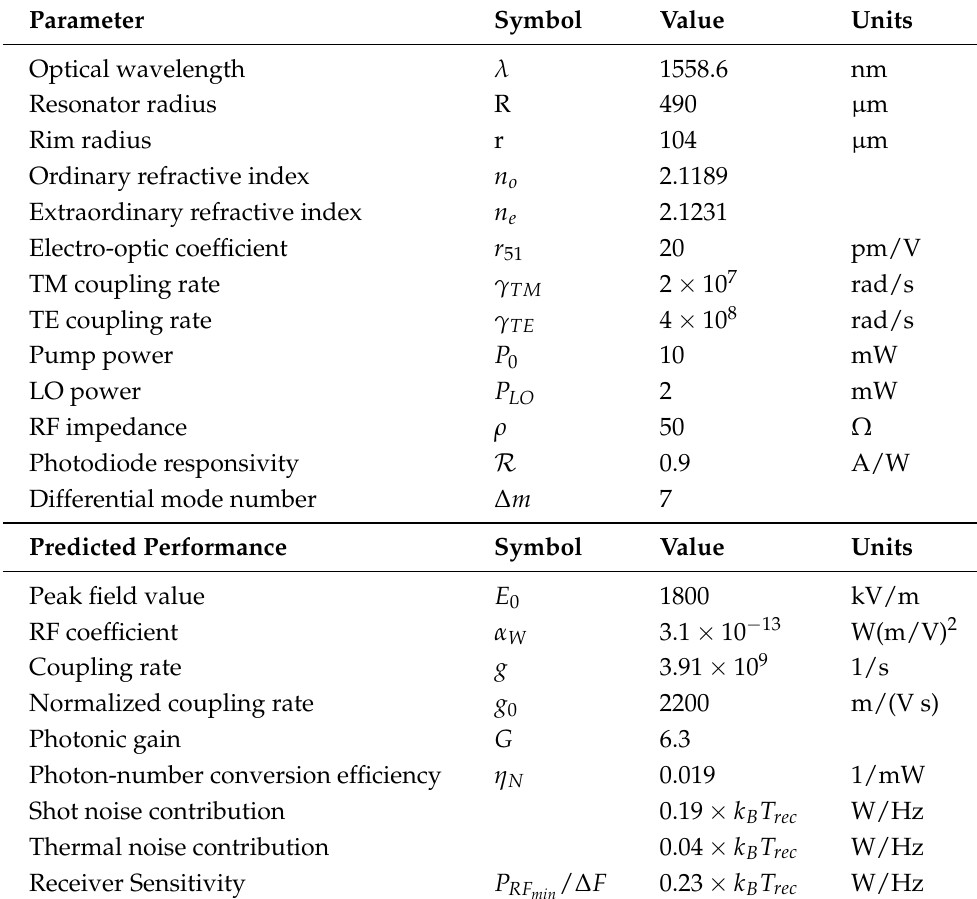
Table 1. The list of parameters used in the numeric estimates of receiver performance and predicted receiver